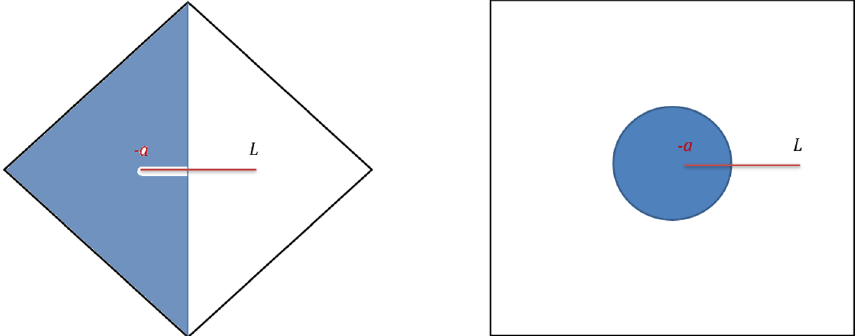
Figure 8 . n -fold cover of effective boundary configuration in Lorentzian signature (left) and Eu- clidean signature